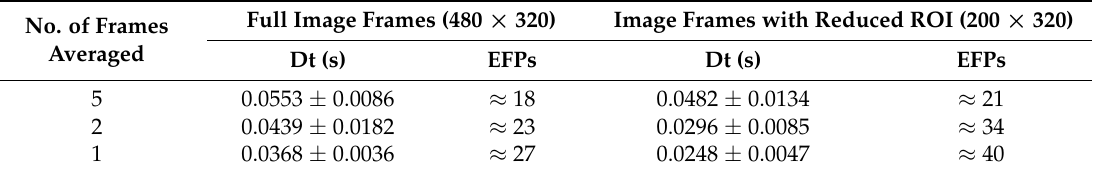
Table 6. Execution time for full and reduced ROI.